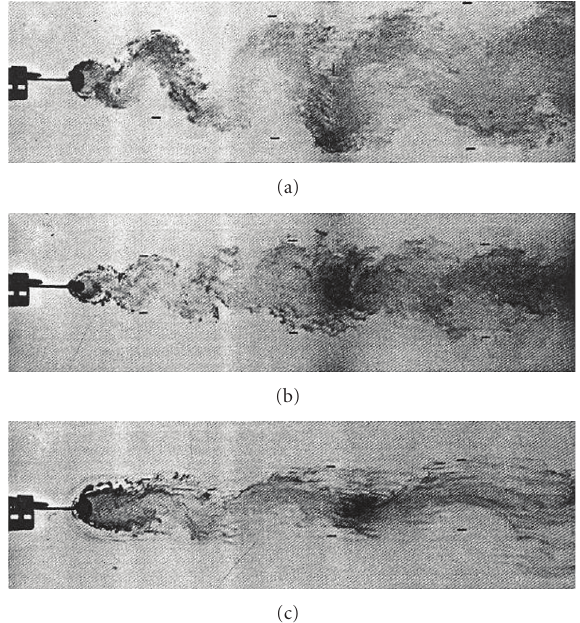
Figure 1: Qualitative demonstration of the e ff ect of the bed on the development of shallow wake (Reproduced with the permission of American Geophysical